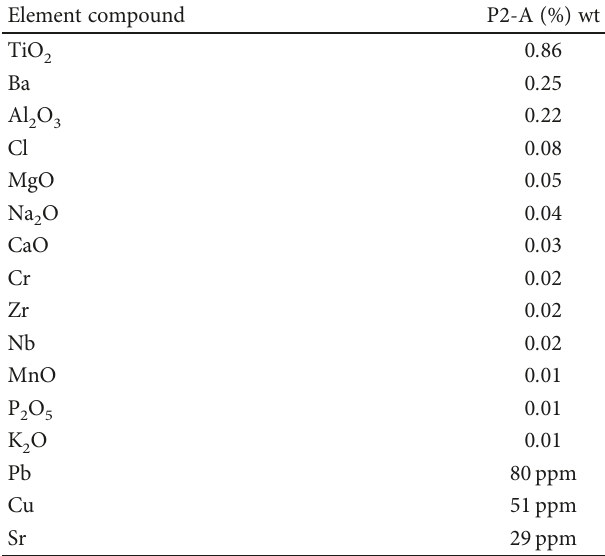
Table 7: XRF analysis of La Mina samples (a) P1-A, (b) P1-B, and (c)